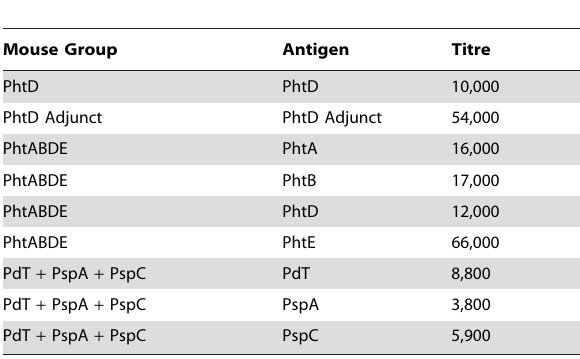
Table 3. Antibody titres of pooled sera from immunised mice before challenge with